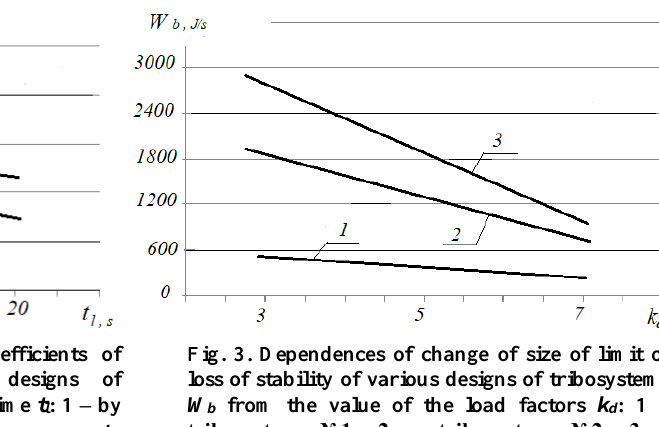
Fig. 3. Dependences of change of size of limit of loss of stability of various designs of tribosystems W b from the value of the load factors k d : 1 – tribosystem №1; 2 – tribosystem №2; 3 – tribosystem